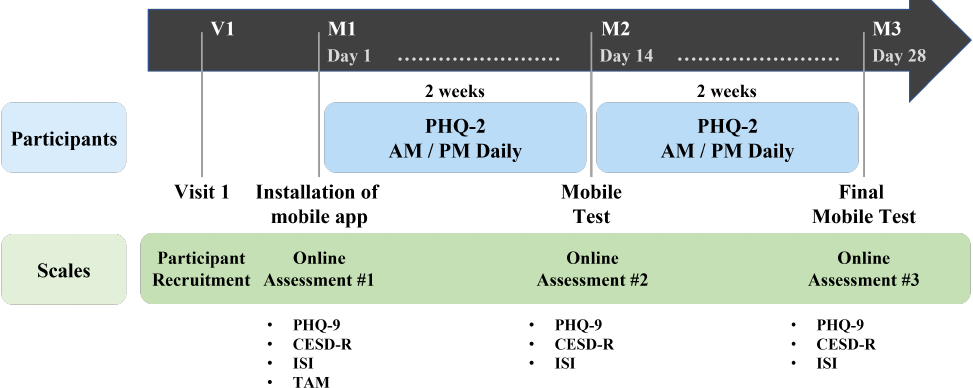
Figure 2. Data Collection Procedure. Among psychiatric outpatients, the data collection procedure was informed to users who agree to participate in the study (V1). When the application installation was completed, data were collected for two weeks (M1–M2) after conducting a survey related to the user’s demographic information and mental health (M1). After the first data collection period, a middle test (M2) was conducted, and the second data collection (M2–M3) was performed for two weeks again. When the second data collection is completed, the final test (M3) was conducted, and the participant’s role in the study